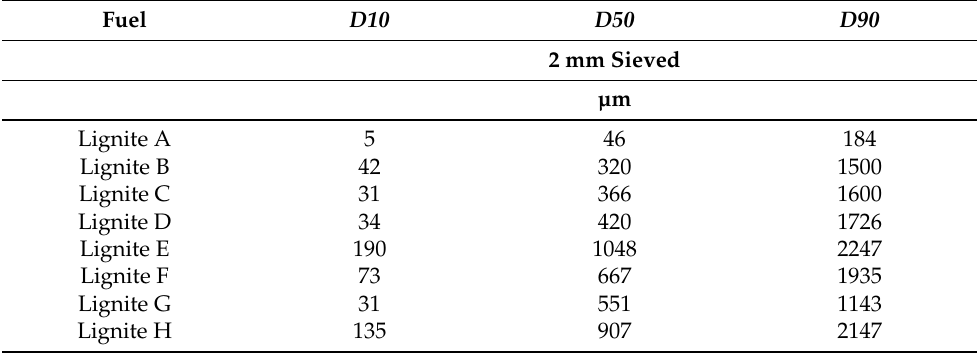
Table 2. Particle size characteristics of pre-dried lignite